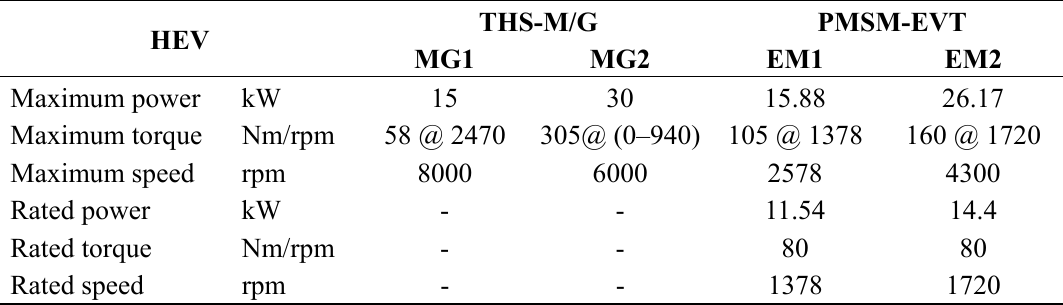
Table 4. Specifications of PM-EVT machines on studied